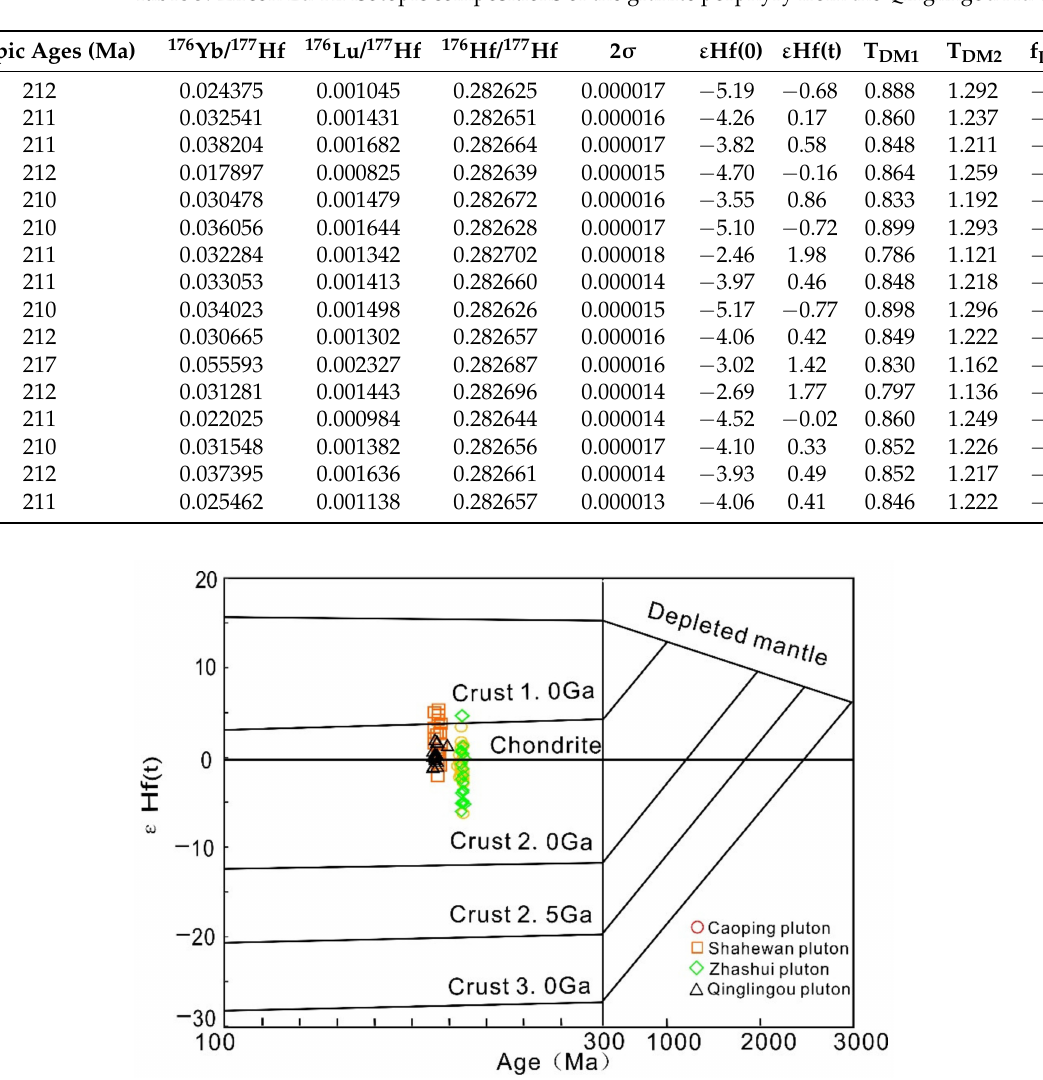
Table 3. Zircon Lu-Hf isotopic compositions of the granite porphyry from the Qinglingou Au deposit.